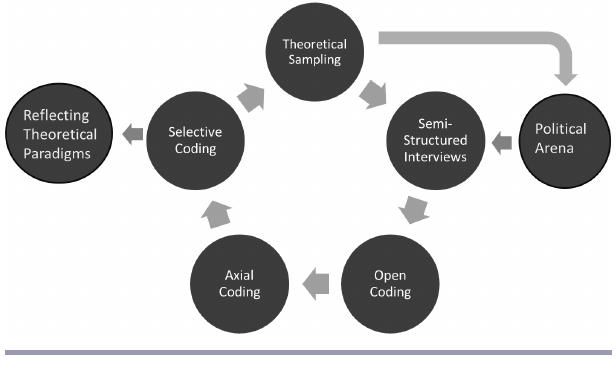
Fig. 1 . Overview of methodological process. Biodiversity experts were selected using theoretical sampling. The semistructured interviews were then analyzed in a three-step coding process. Analytical cycles were repeated until further interviews only confirmed established categorization of narrative groups. The established categories were then used to reflect theoretical paradigms from the literature.